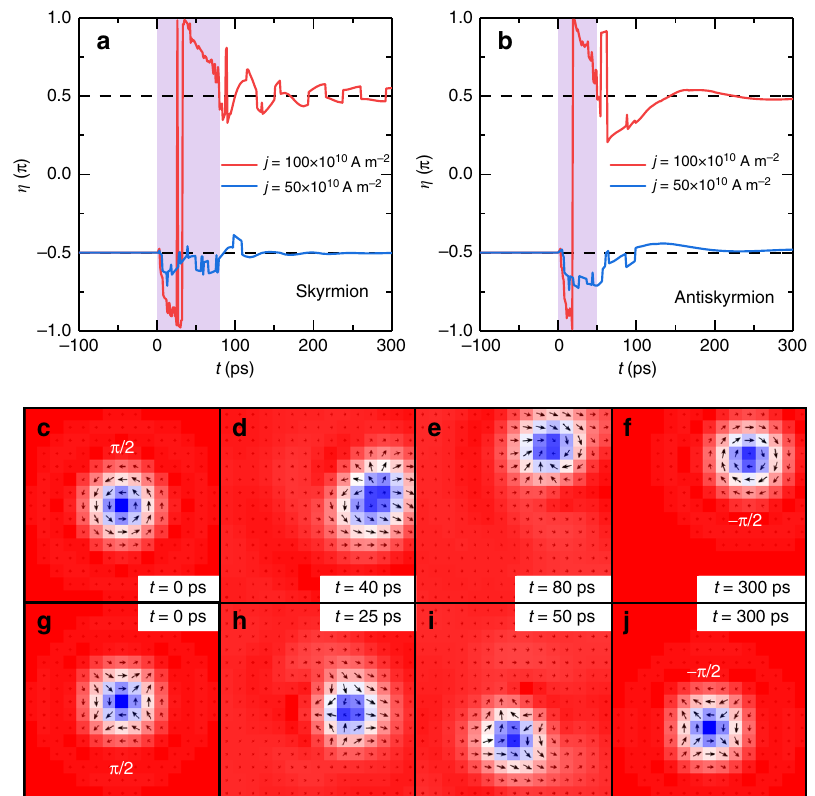
Fig. 7 Flip of the skyrmion (antiskyrmion) helicity induced by a current pulse. a Skyrmion helicity as a function of time. A skyrmion is at rest with the helicity being η = - π /2. The helicity is fl ipped by a strong 80-ps-long current pulse and becomes η = π /2. Such a fl ip does not occur by applying a small current pulse with the same duration. b A similar fl ip occurs also for an antiskyrmion. c – f Snapshots of the skyrmion during the helicity fl ip process. g – j Snapshots of the antiskyrmion during the helicity fl ip process. The model is a square element (39 × 39 spins) with the OBC. The parameters are J 2 = − 0.8, J 3 = − 1.2, K = 0.1, H z = 0.1, and α =